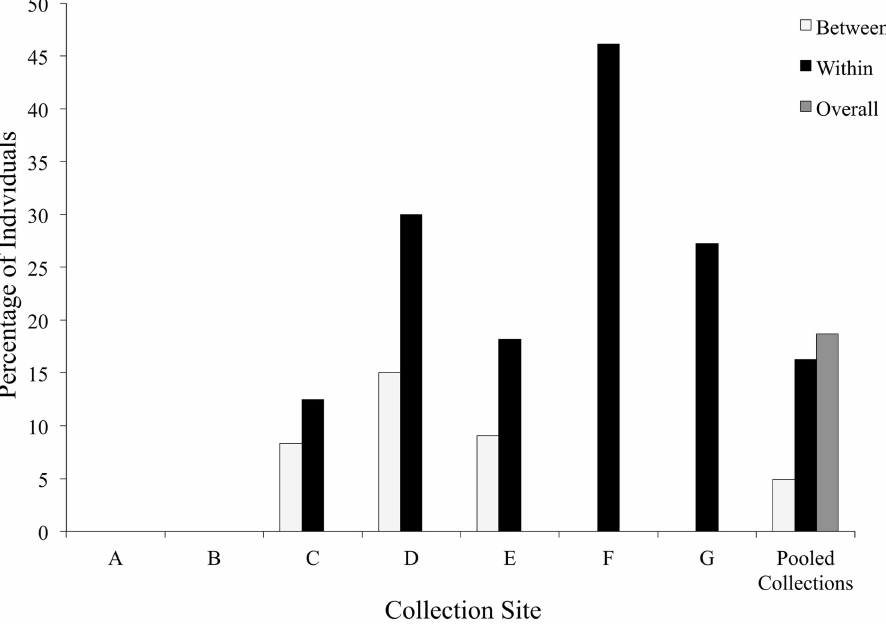
Fig 2. Poa secunda genetic matches within and between local collections. Percentage of Poa secunda individuals with one or more genetic match within (black bars) or between (white bars) local Poa secunda collections.Pooledcollectionsindicate variation in genetic matches within and betweenall collectionsand the overall percentage of individuals with one or more genetic match (gray bar).